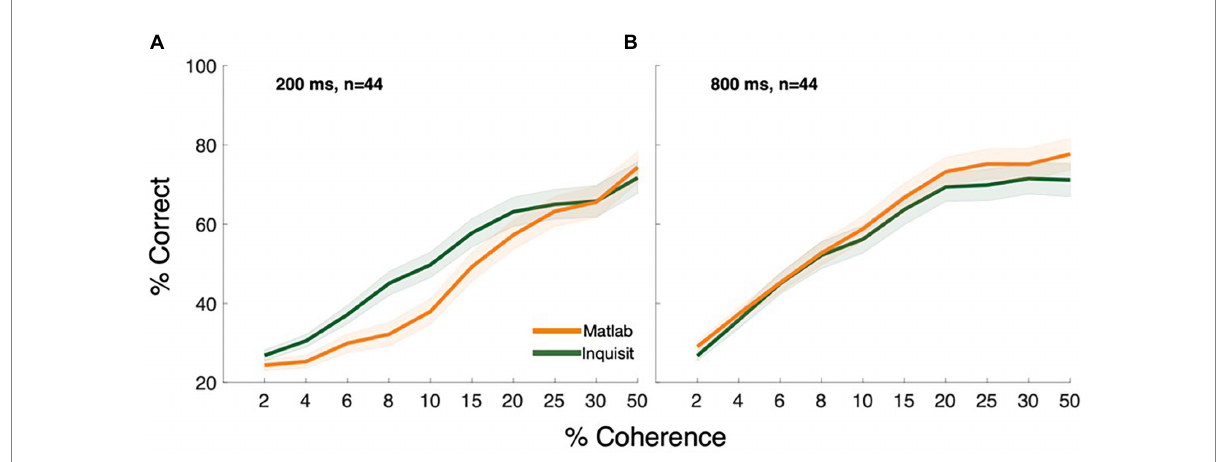
FIGURE 2 Coherence response functions of MATLAB and Inquisit Millisecond at viewing Durations (A) 200 ms and (B) 800 ms. Error is plotted as the standard error of the mean across all